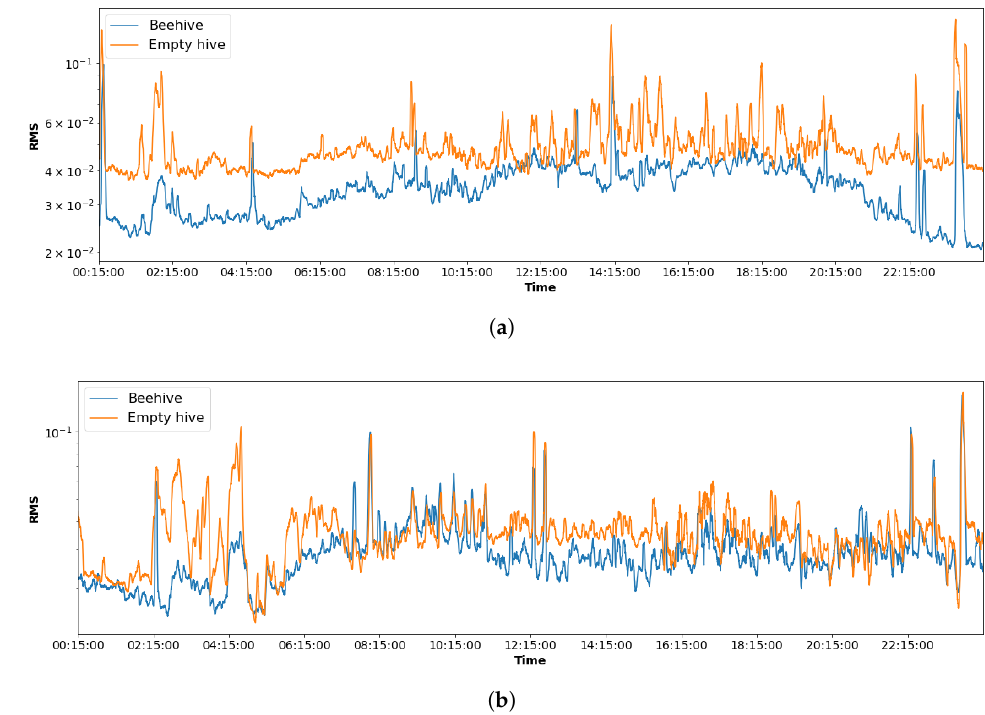
Figure 3. RMS curves of a typical colony with three full boxes of bees (blue curve) and an empty box (orange) as measured on ( a ) 12 August 2021, and ( b ) 24 September